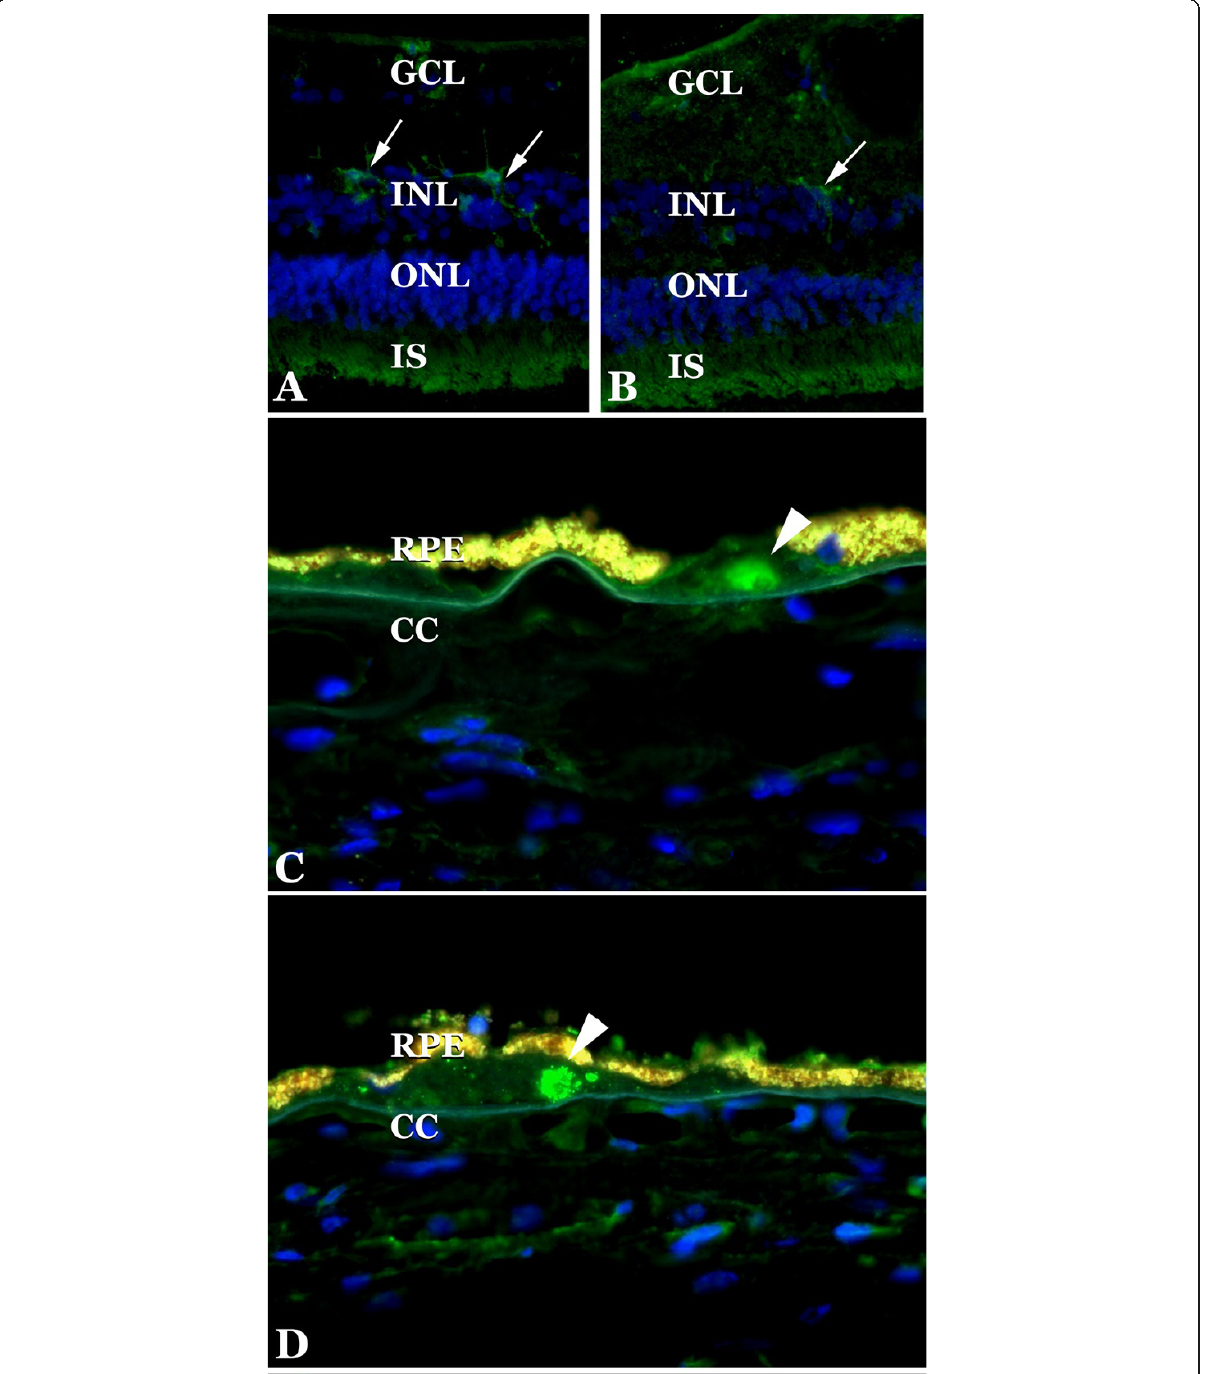
Figure 1 Expression of E-selectin and L-selectin in retina and choroid . Antibodies directed. against E-selectin (A, C) and L-selectin (B, D) were found to react with microglia in some retinas (A, B, arrows) as well as the cores of drusen (arrowheads, C, D). Blue fluorescence is due to DAPI staining. Note the bright yellow autofluorescence of the RPE. GCL, ganglion cell layer; INL, inner nuclear layer; ONL, outer nuclear layer; IS, inner segments; RPE, retinal pigment epithelium; CC,